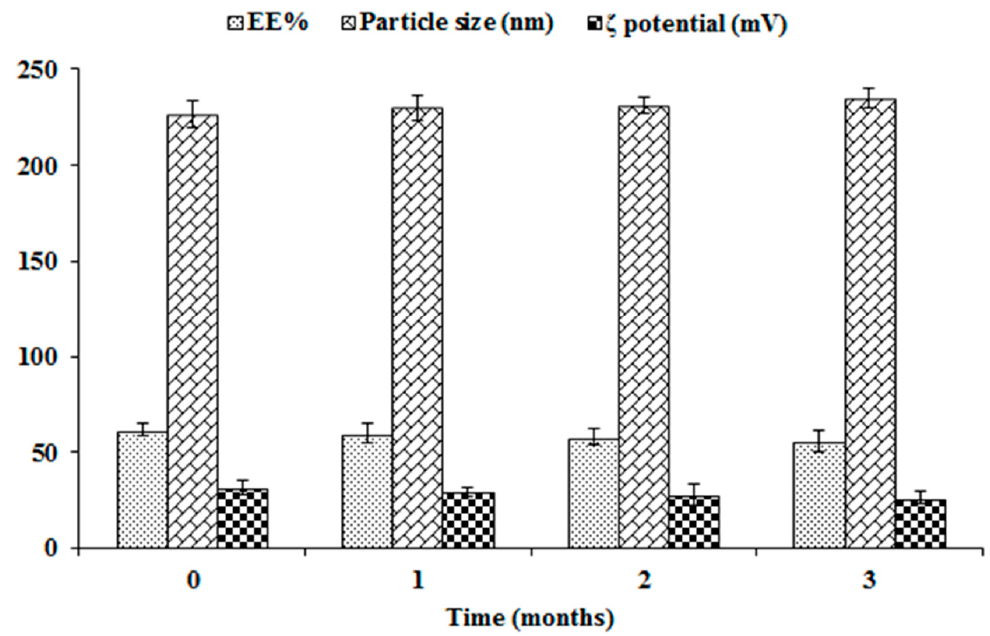
ζ potential of the optimal NFD-CTS-PLGA